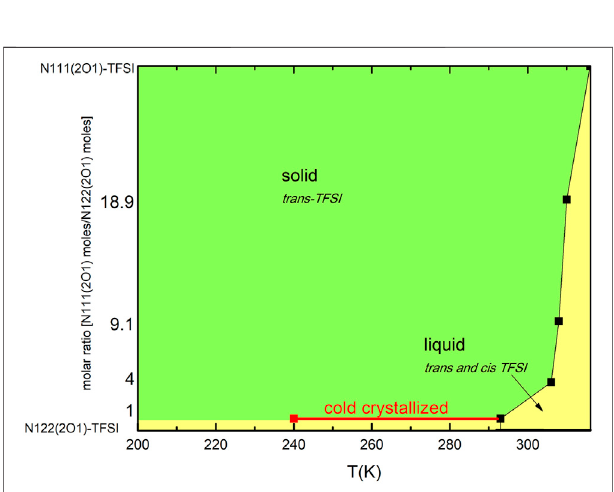
FIGURE7| Schematicpicture ofdifferentphasesshowedonheatingby the mixed system.